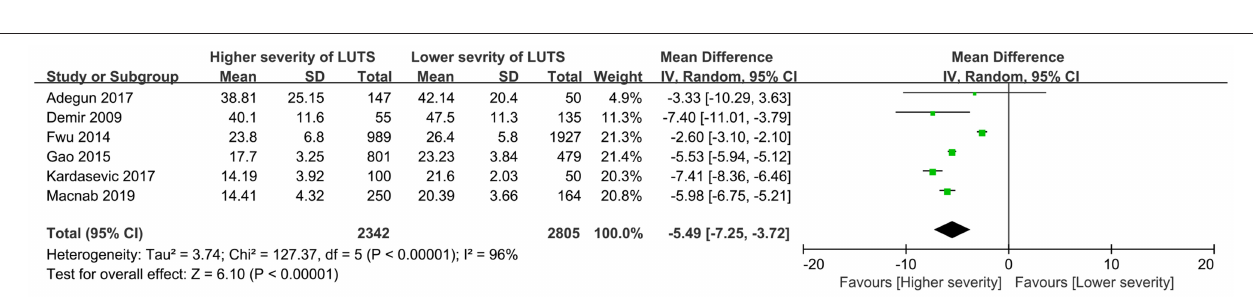
FIGURE 3 | Forest plot showing meta-analysis results of the association between LUTS severity and sexual dysfunction scoring using continuous data. LUTS, lower urinary tract symptoms; CI, confidence interval; SD, standard deviation.